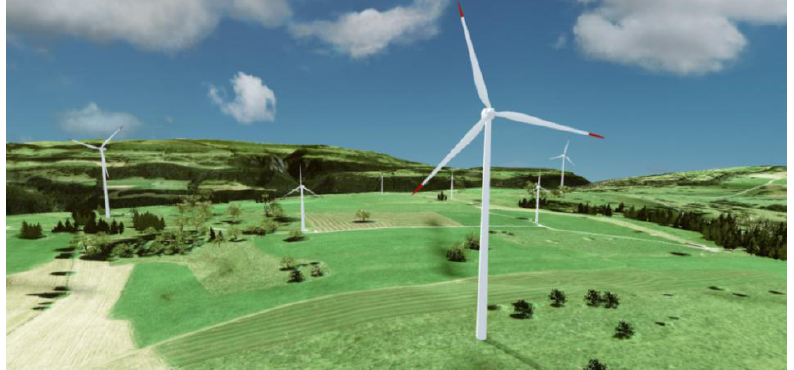
Figure 2. Digital Elevation Model overlaid with an orthophoto and correctly placed wind